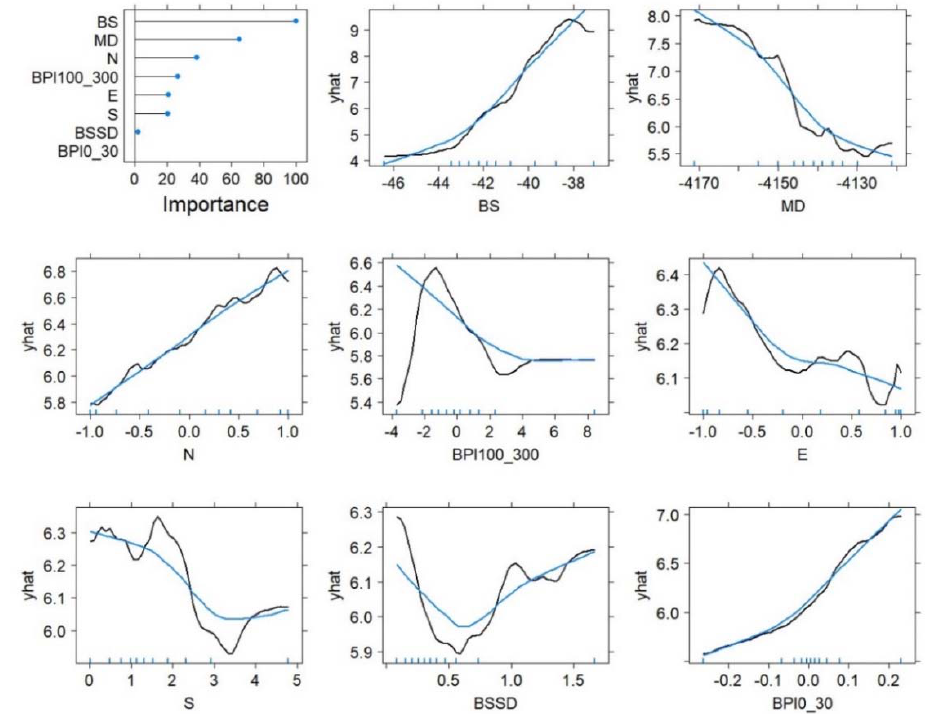
Figure 7. Top left: The QRF variable importance and PDP between PMN and seafloor derivatives. The QRF response curve is represented by a black line; the LOESS curve [133] (blue line) shows the difference between a complex ML algorithm and a simpler non-parametric regression model [122].